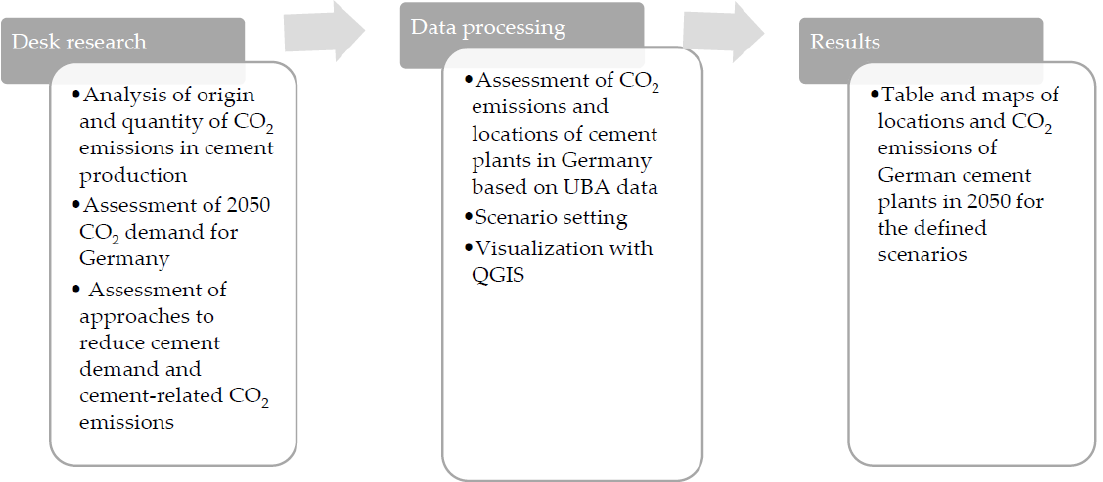
Figure 3. Methodical approach: three scenarios on future CO 2 emissions from cement plants and their locations are derived from a desk research on current cement-related emissions, 2050 cement demand, and available CO 2 emission reduction measures in the cement industry.